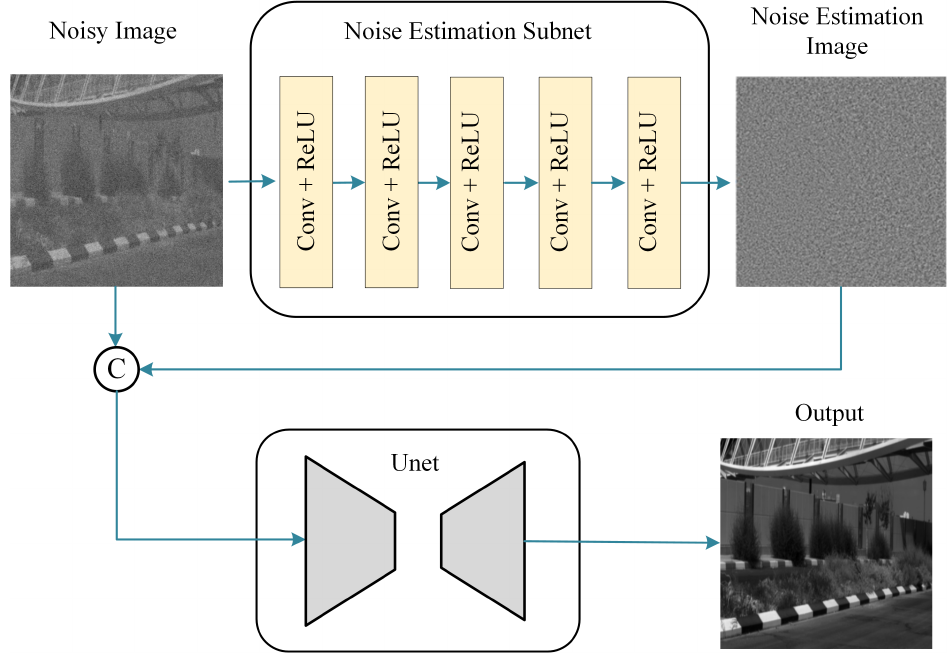
Figure 11. Schematic diagram of the network structure of CBDNet [74]. HSID-CNN: Aiming at the characteristics of high redundancy and correlation of information in HSIs, this network considers the spatial–spectral joint at the input of a convolutional neural network. The end-to-end nonlinear mapping of noisy images and